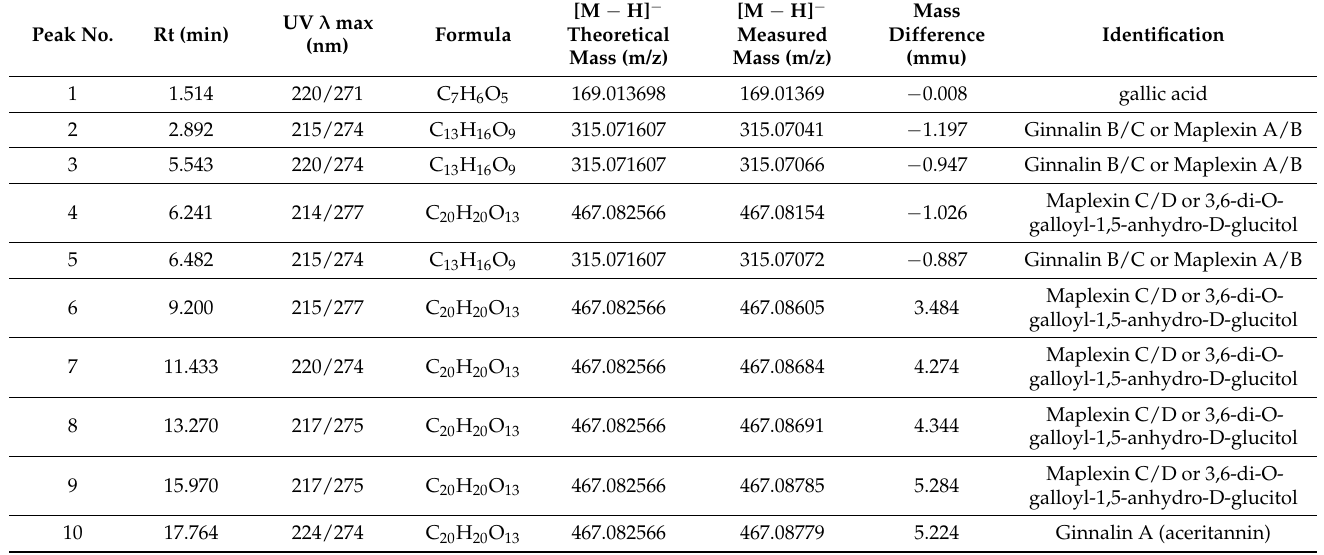
Table 2. The regression equation, limit of detection (LOD), limit of quantification (LOQ), and quantifi- cation result of ginnalin A. In the regression equation, y represents the area of the ginnalin peak in the chromatogram monitored at 270 nm of the UV/Vis detector, and the x-axis unit is mg/L. Compound Regression Equation R² Linear Range (mg/L) LOD (mg/L) LOQ (mg/L)